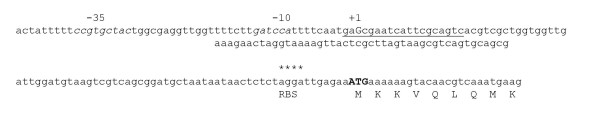
Nucleotide sequence of the promoter region of empA. The 5'-coding sequence and immediate upstream/promoter sequence of empA is presented. The base-paired sequence indicates the annealed primers empA3W and empA3C (Table 2). The transcriptional start site is indicated by +1, the rpoS-dependent promoter regions are indicated as -10 and -35 with the bases in italics [12], and the lux box-like element [19] is underlined. Additionally, the start translation site (ATG) is in bold with the translated product below and the ribosome binding site (RBS) is marked above (*).